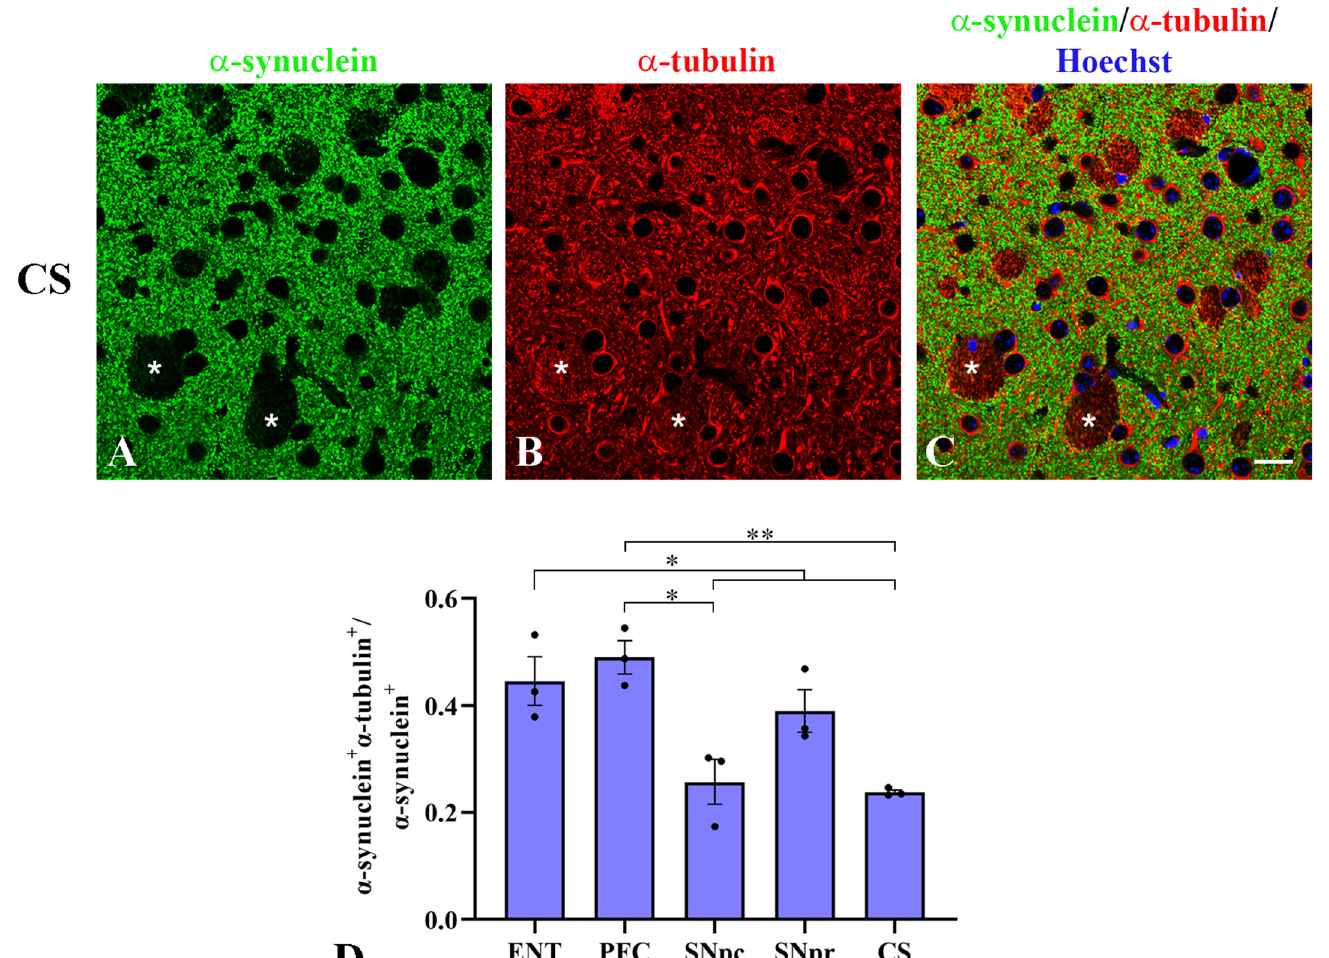
Figure 2. α -synuclein and α -tubulin colocalization in different brain areas of WT mice. ( A – C ): Double immunofluorescence in corpus striatum (CS) of WT mice for ( A ) α -synuclein ( α -syn, green) and ( B ) α -tubulin ( α -tub, red), and ( C ) the relative merge with Hoechst in blue as nuclear staining. Asterisks indicate bundles of fibers. ( D ): Colocalization analysis between α -synuclein and α -tubulin. The bars represent the Manders’ coefficient 1 (M1) computed for each brain area; data are shown as mean ± SEM ( n = 3 mice); one-way ANOVA was used for statistical analysis followed by Bonferroni’s multiple comparison test as described in the Materials and Methods section; * p ≤ 0.05, ** p ≤ 0.01. ENT: entorhinal cortex; PFC: prefrontal cortex; SNpc: substantia nigra pars compacta ; SNpr: substantia nigra pars reticulata ; CS: corpus striatum . Scale bars: 20 µm.